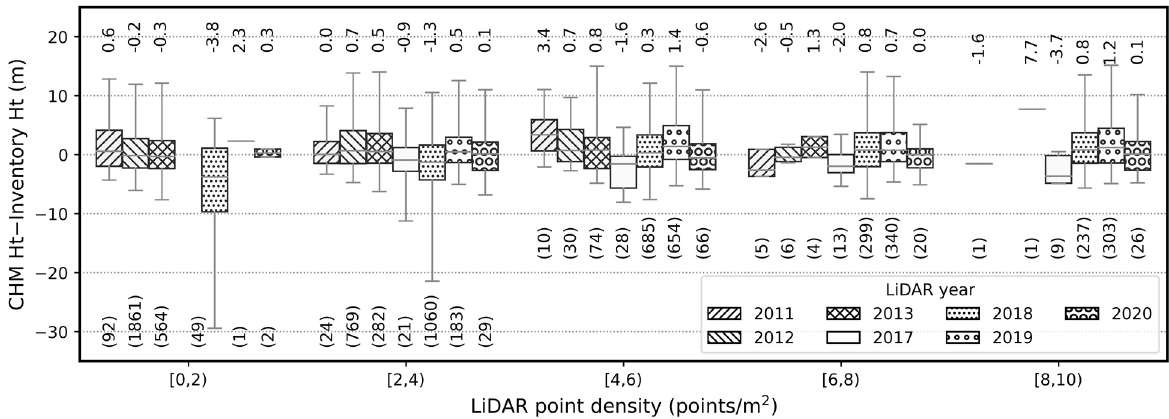
Figure 12. Height measurement error in relation to LiDAR point density and acquisition year. Data with LiDAR density less than 10 points/m 2 were displayed. Boundaries of upper and lower whisker is the ninety-seventh and third percentiles. The number above each box plot is median, and the number below box plot is number of data points. CHM: canopy height model; Ht: height.